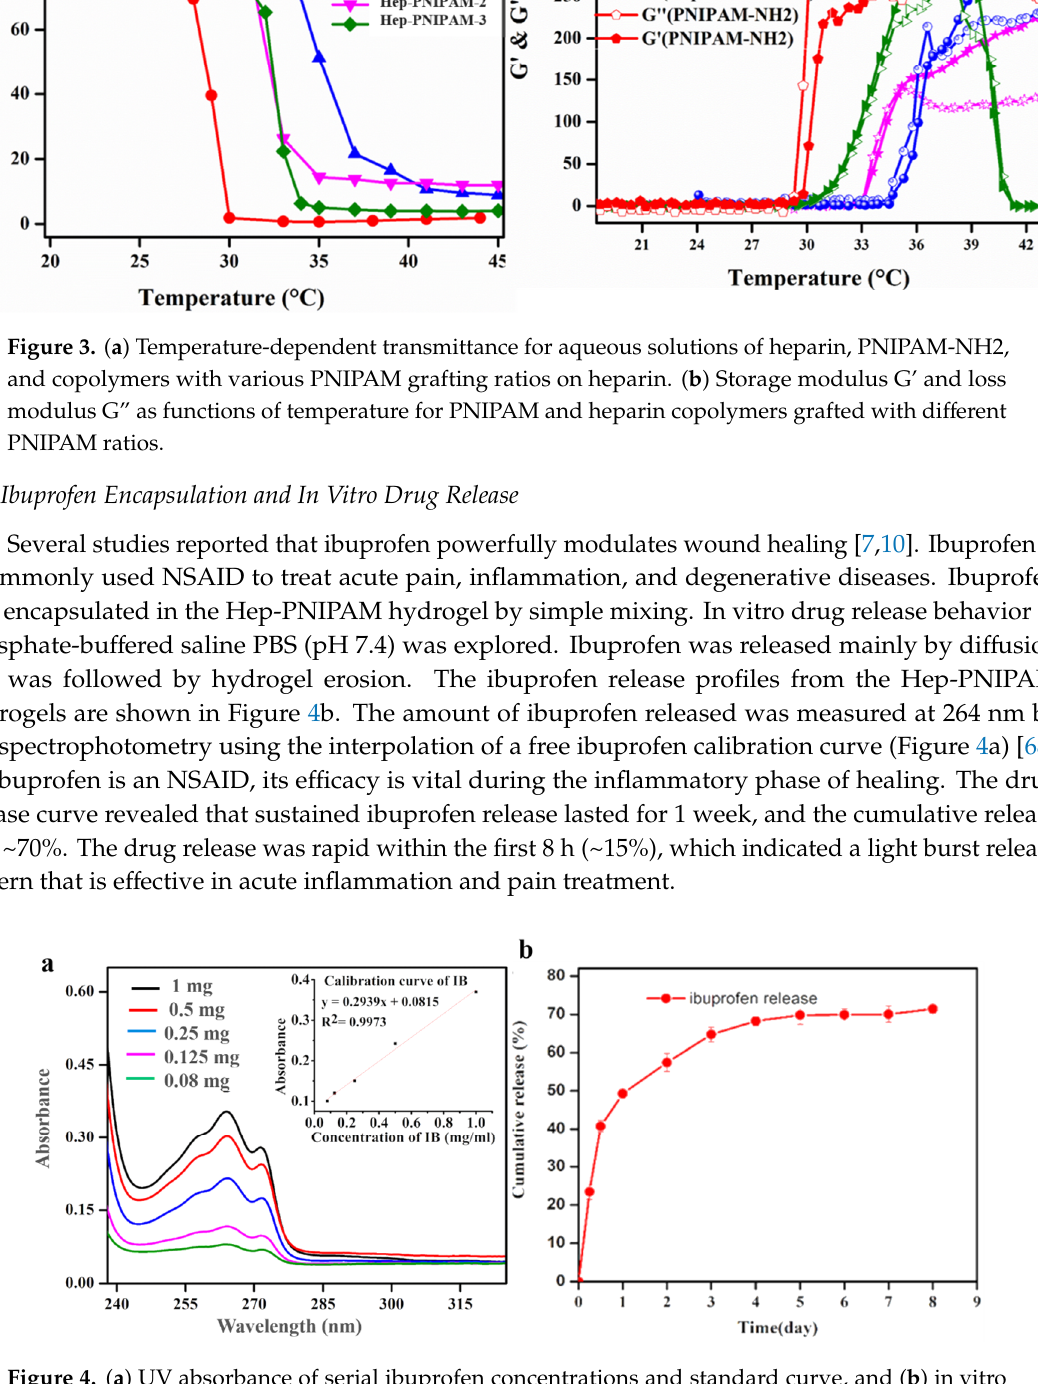
Figure 4. ( a ) UV absorbance of serial ibuprofen concentrations and standard curve, and ( b ) in vitro drug release profiles for ibuprofen-loaded Hep-PNIPAM hydrogel at pH 7.4 and 37